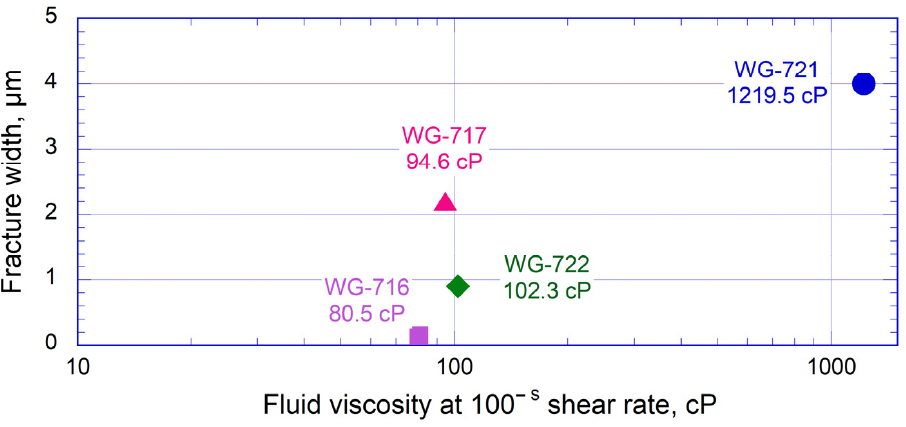
Figure 19. Illustration of the correlation between the fracture width and the fluid viscosity. In addition, the dynamics of HF propagation were investigated. We have found that the HF propagation velocity is highly dependent on the injected fluid viscosity. Figure 20 indicates that injection of lower viscosity fluid induces HF propagation with a higher speed. It can be explained by the high mobility of the low-viscous fracturing fluids, and their ability to easily fill in the microcracks in the fracture process zone. The relationship obtained in the laboratory experiments may be considered for the HF modeling in the field conditions, potentially increasing the reliability of the modelling.